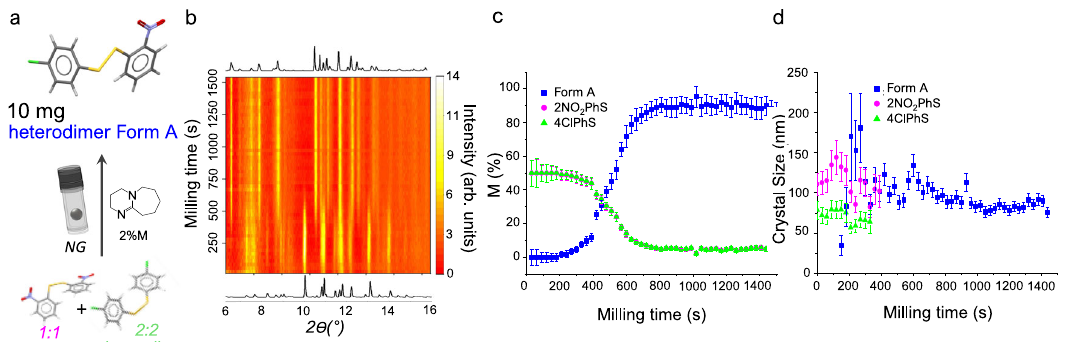
Fig. 6 TRIS-XRPD for Reaction IV, the disul fi de exchange reaction between bis(2-nitrophenyl) and bis(4-chlorophenyl) disul fi de base catalysed by dbu (2 M%) with 10 mg loading under ball mill neat grinding (NG) conditions. a The reaction scheme for the disul fi de exchange reaction, with atoms coloured: white-hydrogen; grey-carbon; blue-nitrogen; red-oxygen; yellow-sulfur; green-chlorine. b Heat maps (linear intensity, arb. units) of TRIS-XRPD with empirical background-subtracted data for Reaction IV, alongside 1D calculated diffraction pro fi les for the mixture of starting reagents (homodimers) and fi nal product phase. c Quantitative phase analysis of Reaction IV as obtained by Rietveld re fi nements, shown as molar fraction of starting materials (pink and green) and product phase (blue) with relative ESD bars. d Scherrer crystal size obtained from pro fi le analysis of the TRIS XRPD data with relative ESD bars (see Supplementary Note 5.5 for details) are shown for phases more abundant than